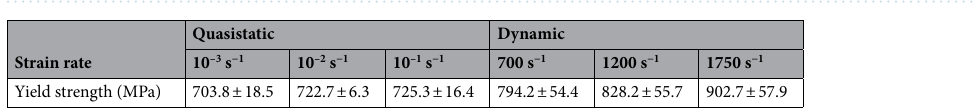
Table 1. Average compressive yield strength at quasistatic and dynamic strain